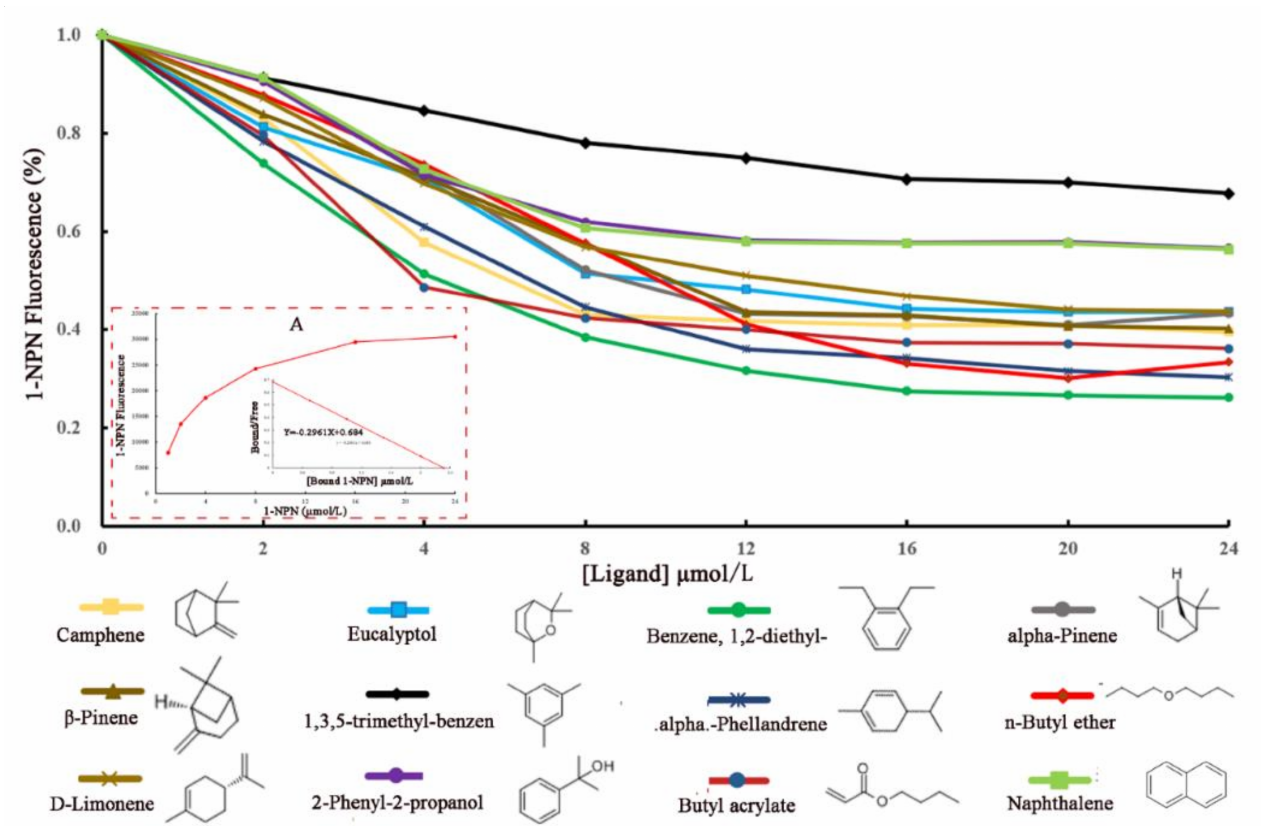
Figure 3. Fluorescence competitive binding assay of EsigGOBP1. (A) The binding curve and Scatchard analysis of EsigGOBP1 and